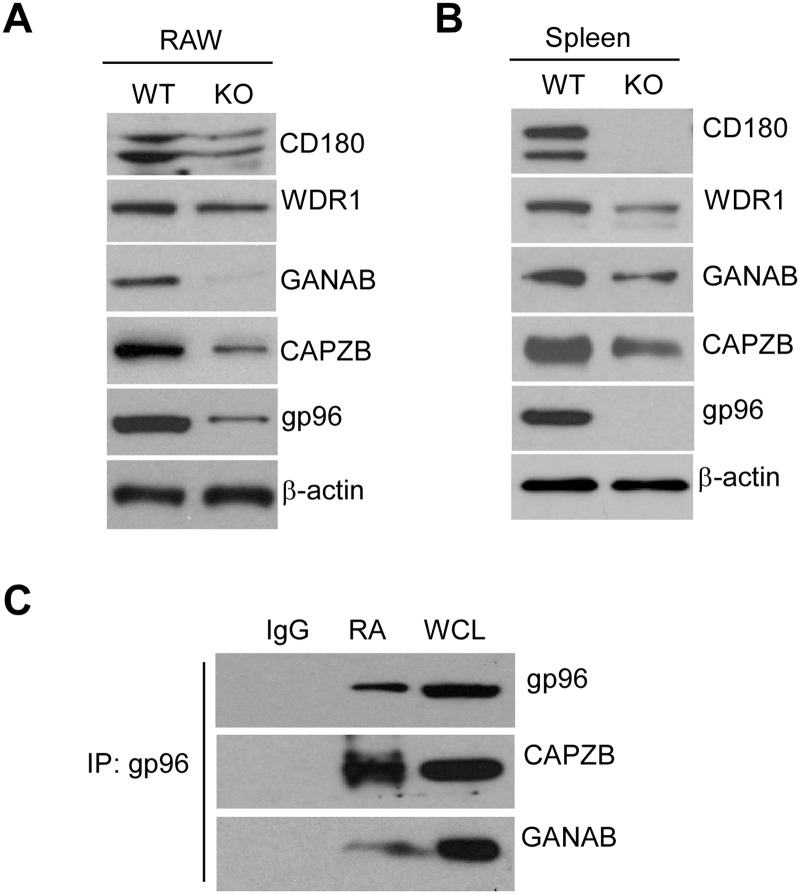
Proteins reduced in gp96 KO cells or tissues.A and B) Protein levels of CD180, WDR1, GANAB, CAPZB and gp96 in WT and KO gp96 RAW cells (A) or spleen tissues (B) were measured by Western blot. β-actin was a loading control. C) Anti-gp96 precipitates were resolved by SDS PAGE, and GANAB, CAPZB and gp96 were immunoblotted. IgG is an isotype control for Immunoprecipitation. WCL: whole cell lysate input.